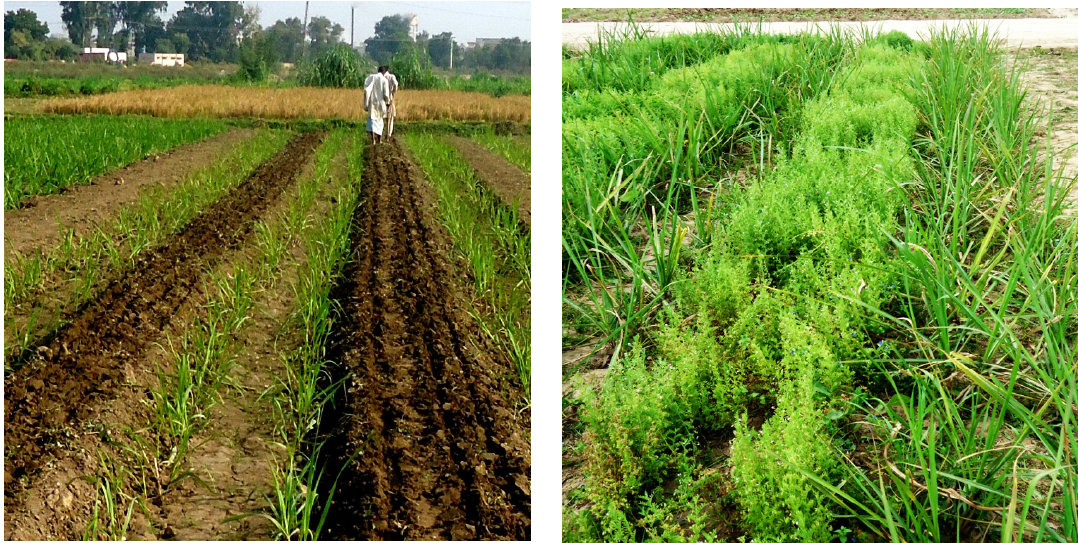
Figure 2. Lentil intercropping in sugarcane.